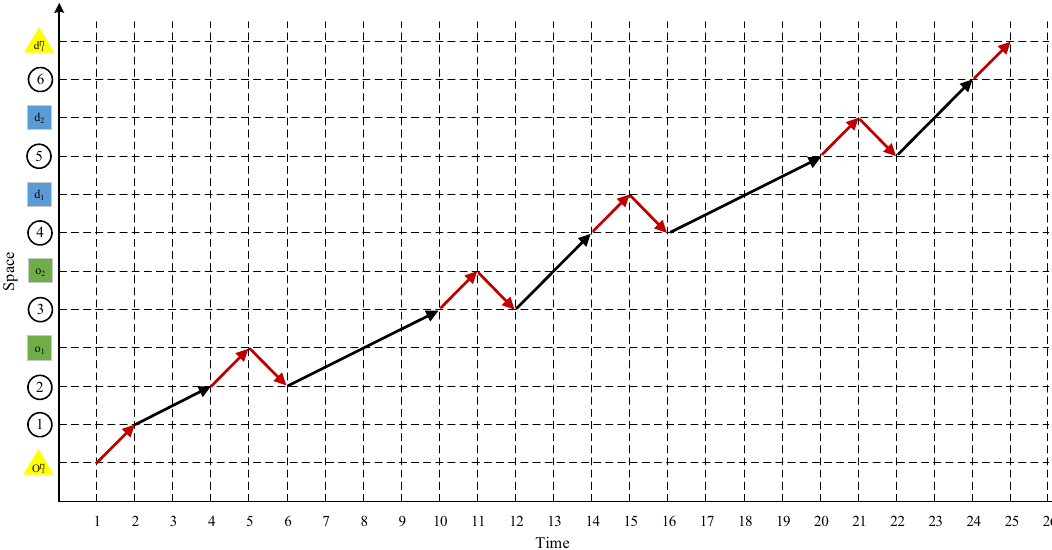
Fig. 10 Space–time trajectory of the vehicle for the example with extended link travel time